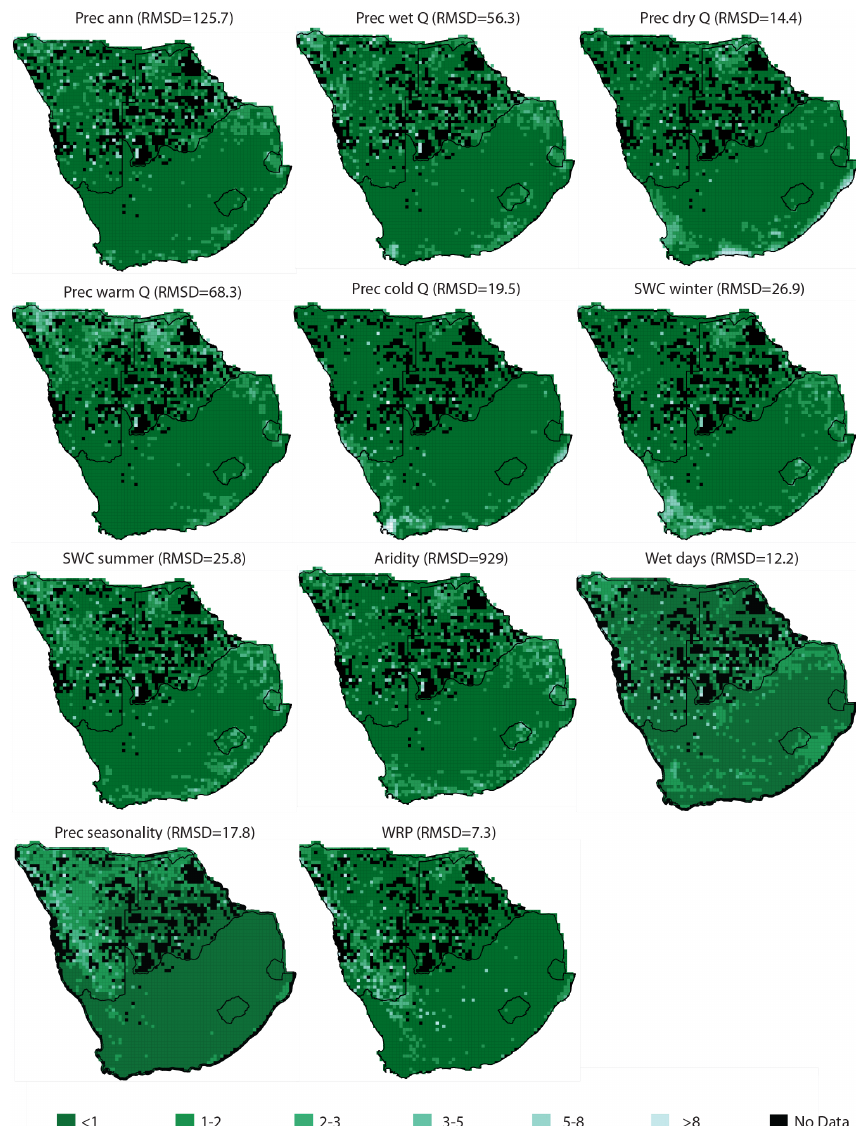
Figure 6. Geographical distributions of the normalized anomalies of the reconstructions of moisture-like variables (Eq. 13). The scale is identical for all the maps, in units of RMSD. No vegetation information was available from the black